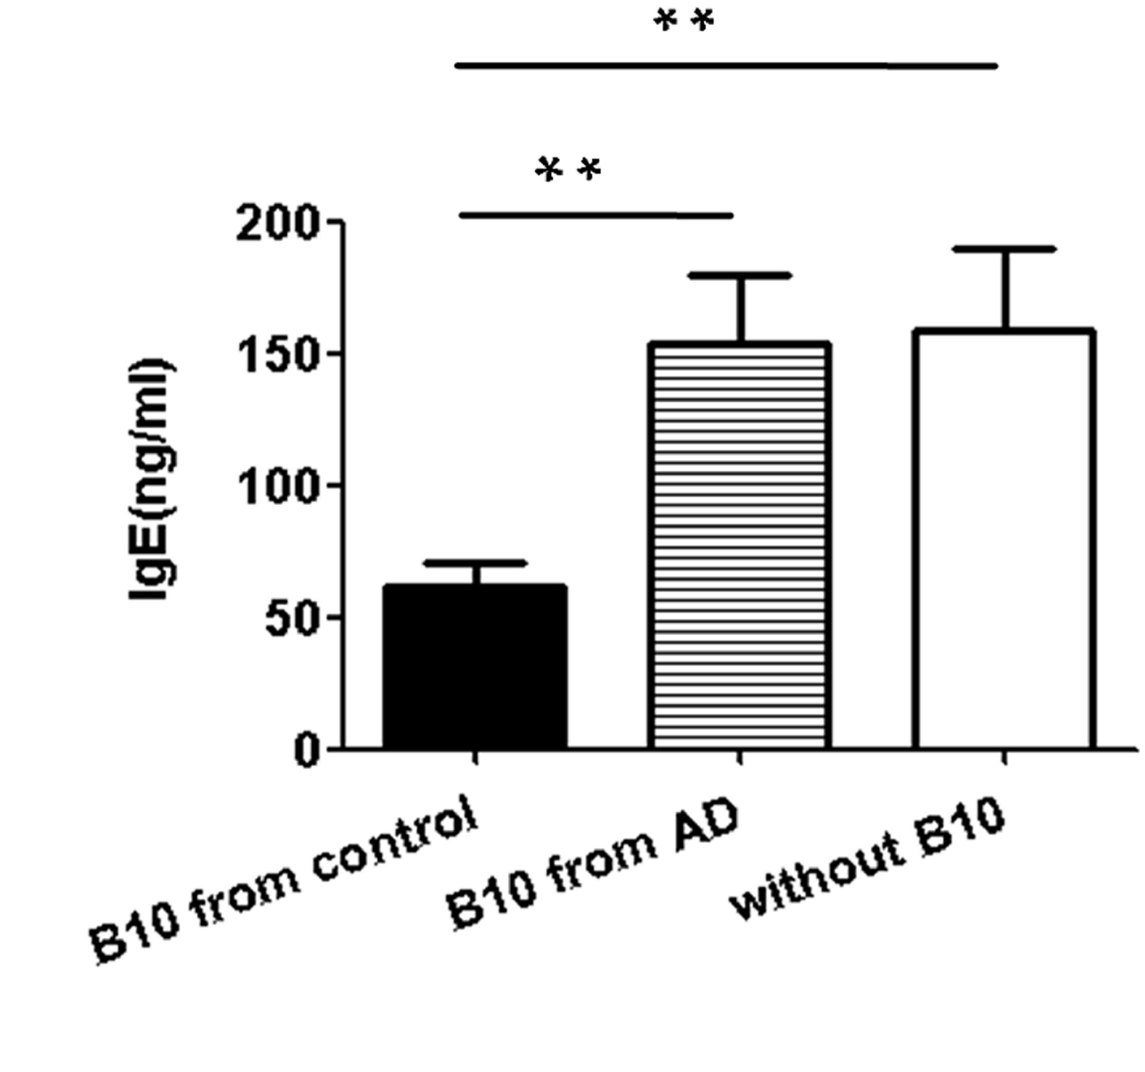
Fig 3. Influence of CD5 + CD19 + CD1d hi B10 cells on IgE production. B10 cells were sorted from the spleen of AD mice (n = 5) and control mice (n = 5) by flow cytometry. The PBMCs from normal mice and B10 cells from control or AD mice were cultured with LPS (10 μ g/mL), PMA (50 ng/mL), and iono (500 ng/ mL) for 72h,then the IgElevels were determined in the supernatants by ELISA.PBMCs without B10 cell wereused as a negative control. No differences in IgE levels were observed in the AD and negative control groups, and both groups showed significantly higher IgElevel than that observed in the control group. Data are expressed as mean ± SEM. ** P < 0.01, as analyzed by one-way ANOVA, followed by Tukey multiple-comparison test.